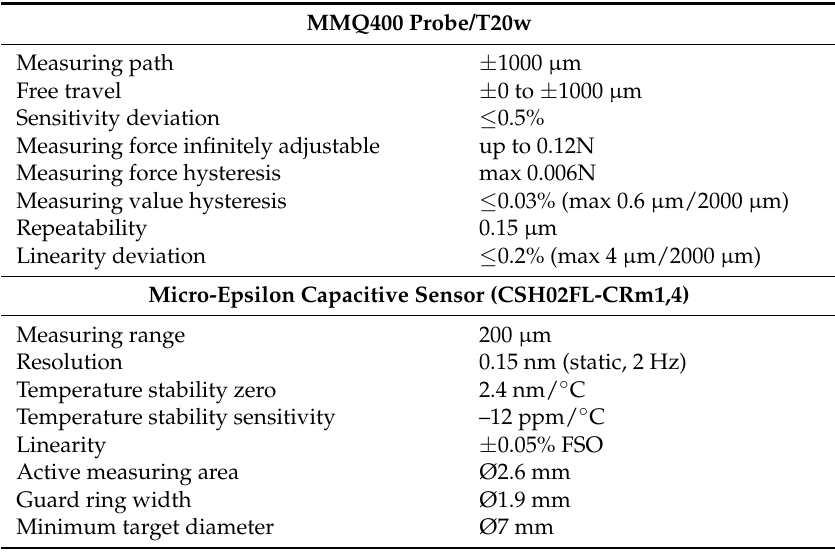
Table 1. Detailed parameters of contact probe and capacitance sensor.